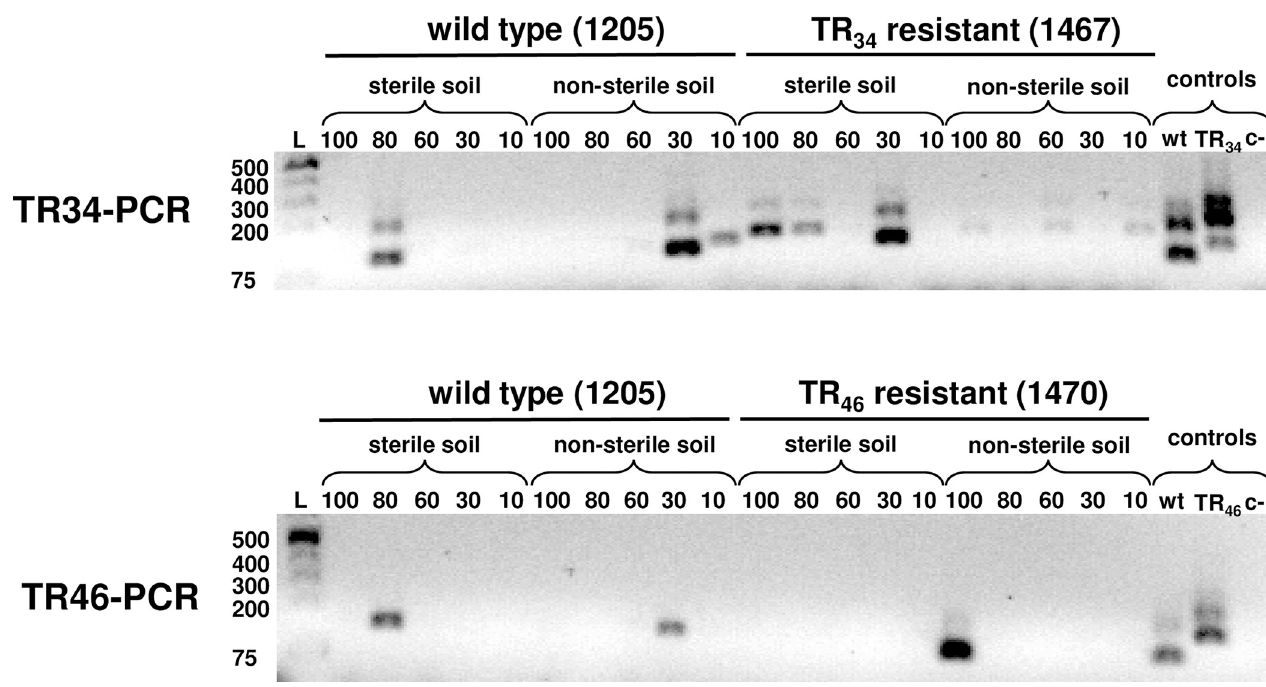
Fig 2. Sensitivity of the TR34-PCR and TR46-PCR assays. Assays were conducted for soil samples and autoclaved soil samples spiked with different quantities of conidia of A . fumigatus , including 100, 80, 60, 30, and 10 conidia per ml. The assays were also conducted on soil samples sterilized prior to spiking with conidia of A . fumigatus . Controls in the PCR assays included isolates 1205 (wt), and 1467 (TR 34 ) or 1470 (TR 46 ) as positive controls and sterile distilled water as the negative control (c-).